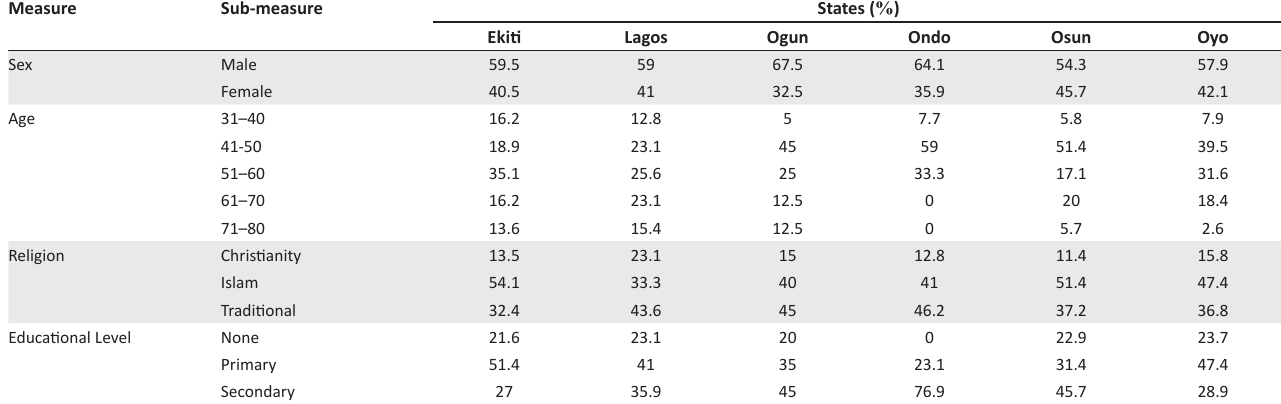
TABLE 1: Demographic distribution of TMP’s by state.